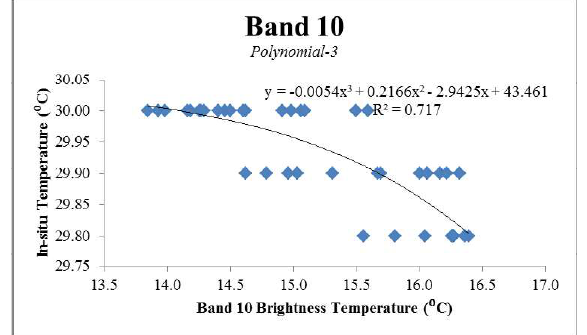
Figure 4. Relation of band 10 BT and Measured Sea Surface Temperature